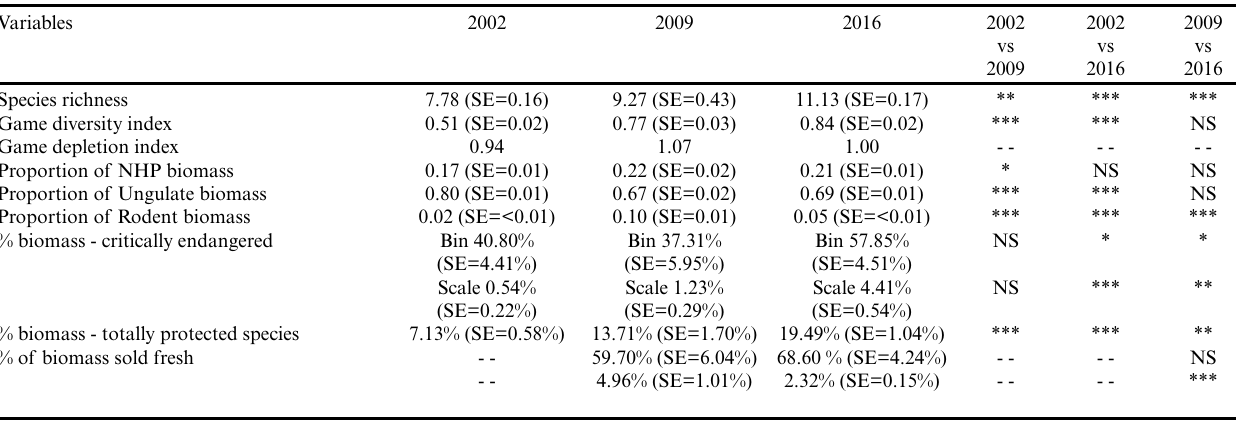
Table 3 . Summary statistics for sustainability indicators shown as mean per sampling day per period and the corresponding results of statistical analysis comparing means across combinations of sampling periods. (- - = not possible, NS = nonsignificant, * = p < 0.05, ** = p < 0.01, *** = p <